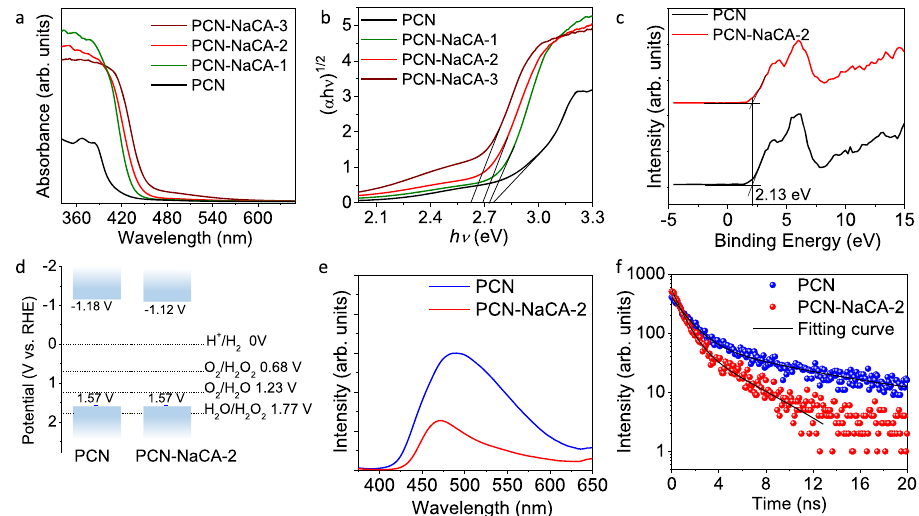
Fig. 4 Excitation and quenching properties of the photocatalysts. a UV – Vis diffuse re fl ectance spectra of the photocatalysts: PCN polymeric carbon nitride, PCN-NaCA-1 – PCN-NaCA-3 polymeric carbon nitride with a various amount of sodium cyanaminate moieties. b Plots of transformed Kubelka – Munk function versus photon energy. Colors in a and b : PCN, black; PCN-NaCA-1, olive; PCN-NaCA-2, red; PCN-NaCA-3, wine. c Valence band X-ray photoelectron spectra of PCN (black) and PCN-NaCA-2 (red). d Band structure of PCN and PCN-NaCA-2. e Steady-state photoluminescence spectra of PCN (blue) and PCN-NaCA-2 (red) under 355 nm excitation. f Time-resolved photoluminescence (TRPL) spectra of PCN (blue) and PCN-NaCA-2